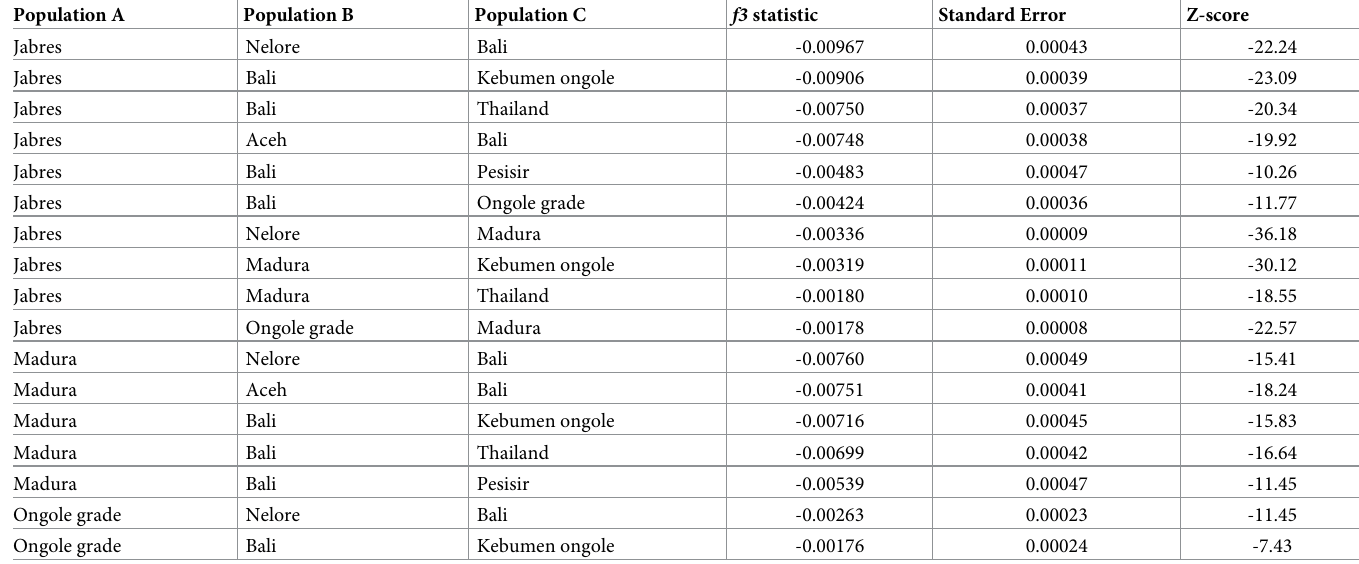
Table 2. The most significant f3 statistics showing the possible ancestors mixtures in Jabres, Madura, and Ongole grade cattle population. Population